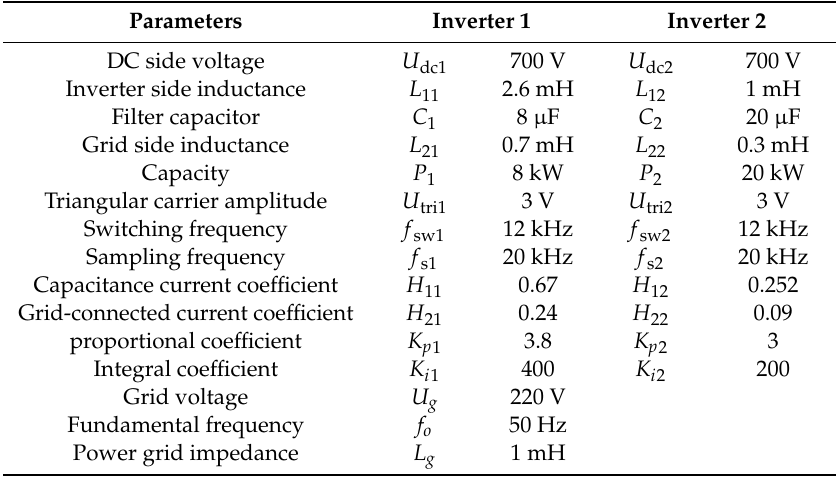
Table 1. Main parameters of grid-connected